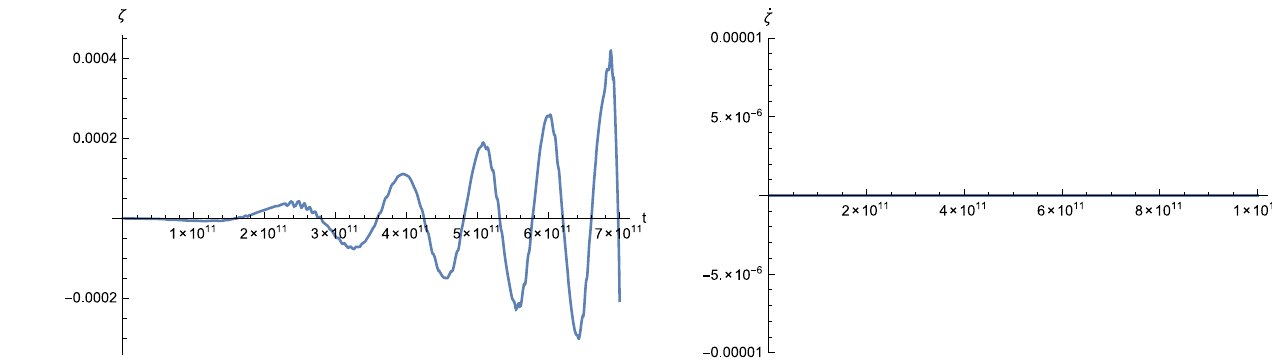
Fig. 8 The numerical plot of ˙ ζ in terms of the cosmic time t after cur- vaton domination. We choose the parameters as ξ = 1, M = 10 − 4 M p , m = 10 − 6 M p . The initial conditions for δϕ are δϕ i = 10 − 4 M p , ˙ δϕ = i